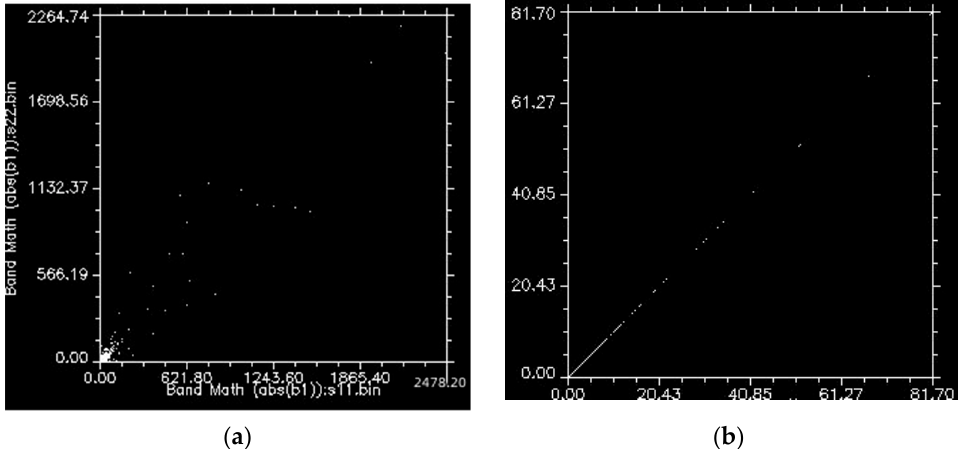
Figure 3. The scatterplot between ( a ) HH and VV polarizations and ( b ) HV and VH polarizations of L-band SAR data.